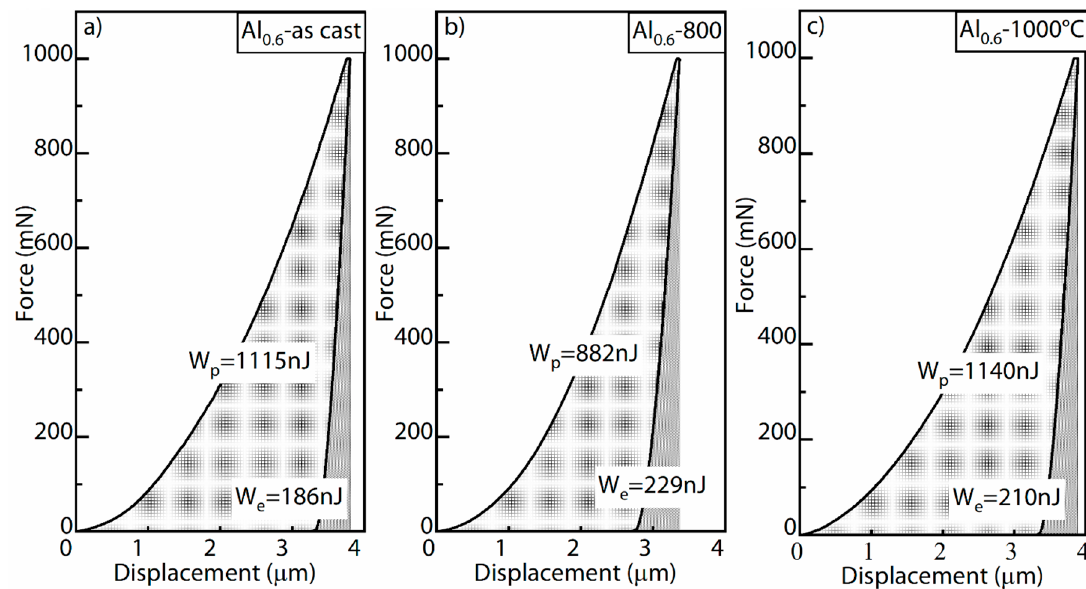
Figure 10. Force-displacement curves of Al 0.6 : ( a ) as-cast, ( b ) heat-treated at T = 800 °C and ( c ) heat-treated at T = 1000 °C.